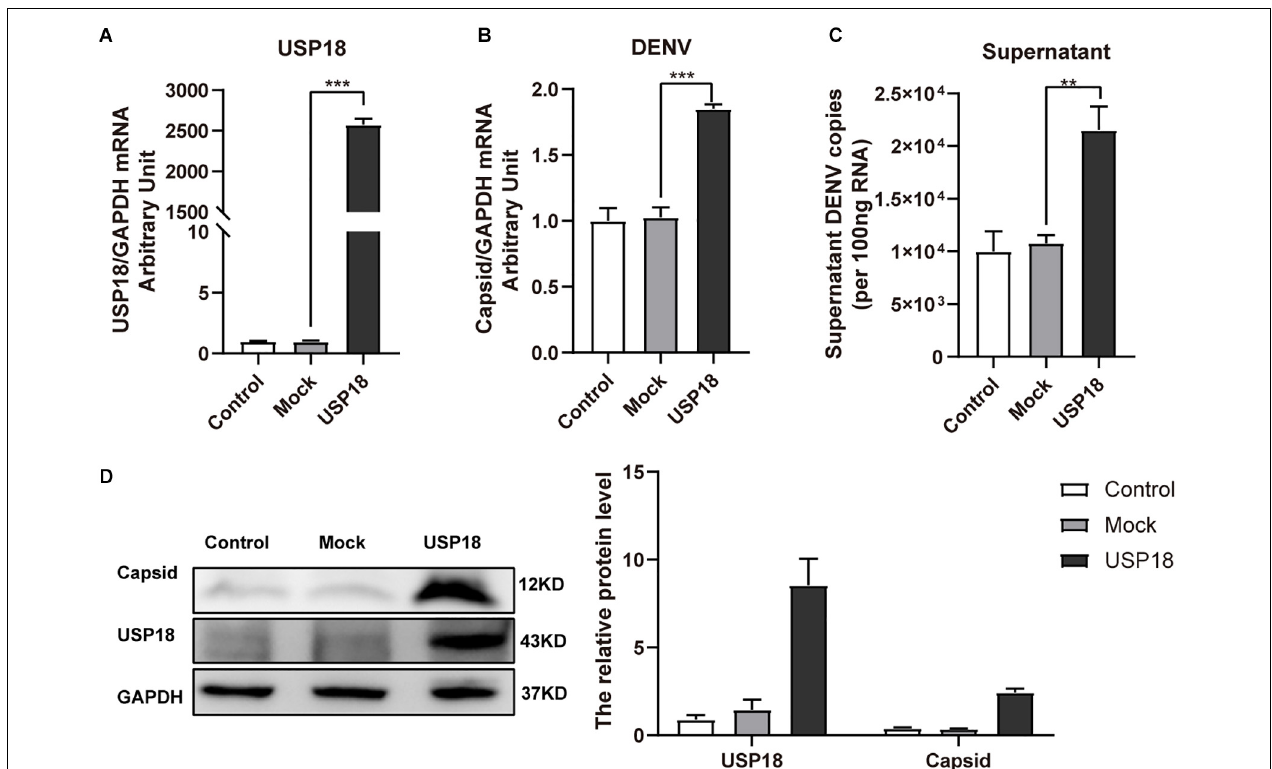
FIGURE 2 | Over-expression of USP18 promotes DENV-2 replication in Hela cells. Hela cells were transfected with USP18 plasmid or empty vector (mock). Eight hours after transfection, cells were infected with DENV-2 (MOI = 1). Cells and culture medium were collected at 48 h post-infection. USP18 mRNA (A) and levels of DENV-2 RNA (B,C) were determined by real-time PCR. Results were normalized to GAPDH shown as arbitrary units (fold change). Cell lysates were prepared for Western blot analysis of DENV-2 capsid and USP18 expression with GAPDH as a loading control (D) . Control is cells infected with DENV-2 only. Data are presented as mean ± SD. Error bars indicate SD; ** P < 0.01, *** P <